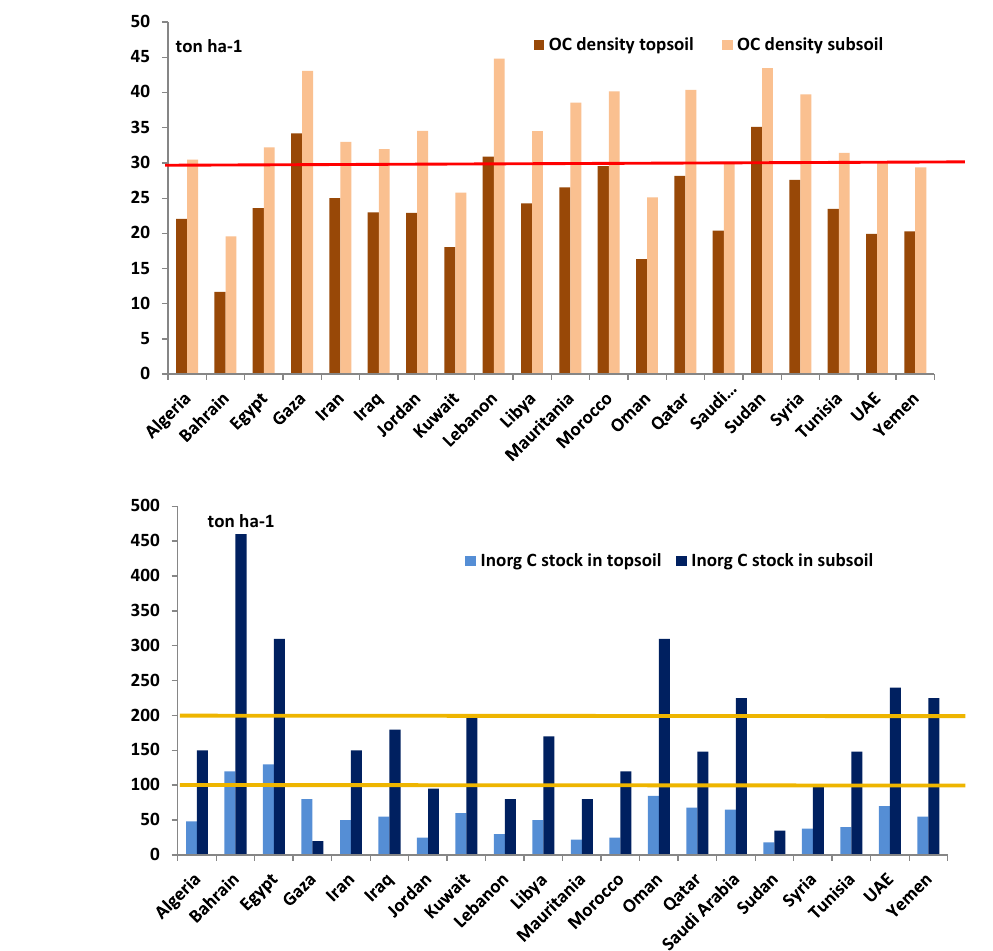
Figure 7. Soil organic carbon and soil inorganic carbon density (tonsha − 1 ) in the topsoil (0–0.3m) and subsoil (0.3–1.0m) of the 20 coun- tries and territories in the NENA region. The red line represents the threshold for organic carbon, and the yellow lines correspond to the limits of classes for inorganic